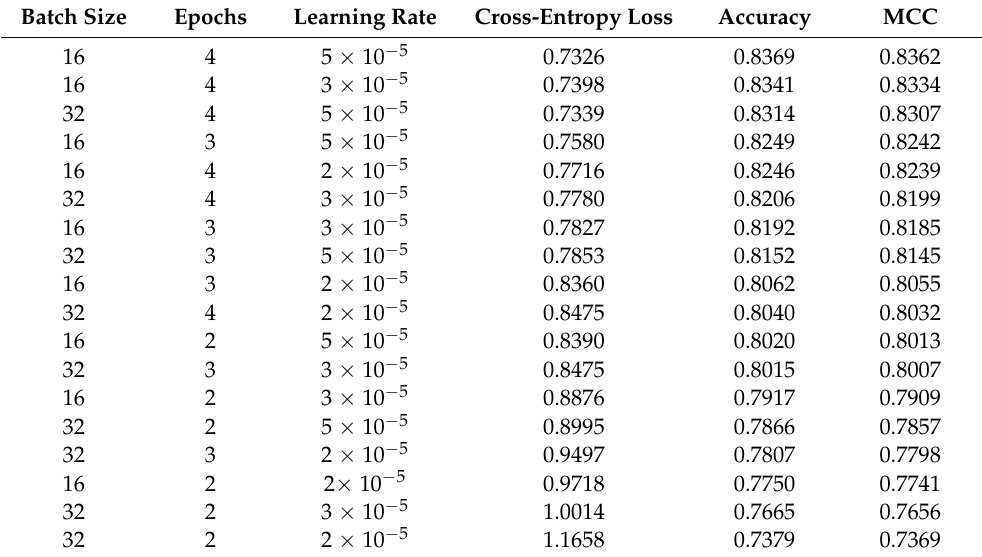
Table 3. Multilingual BERT results for Chapter